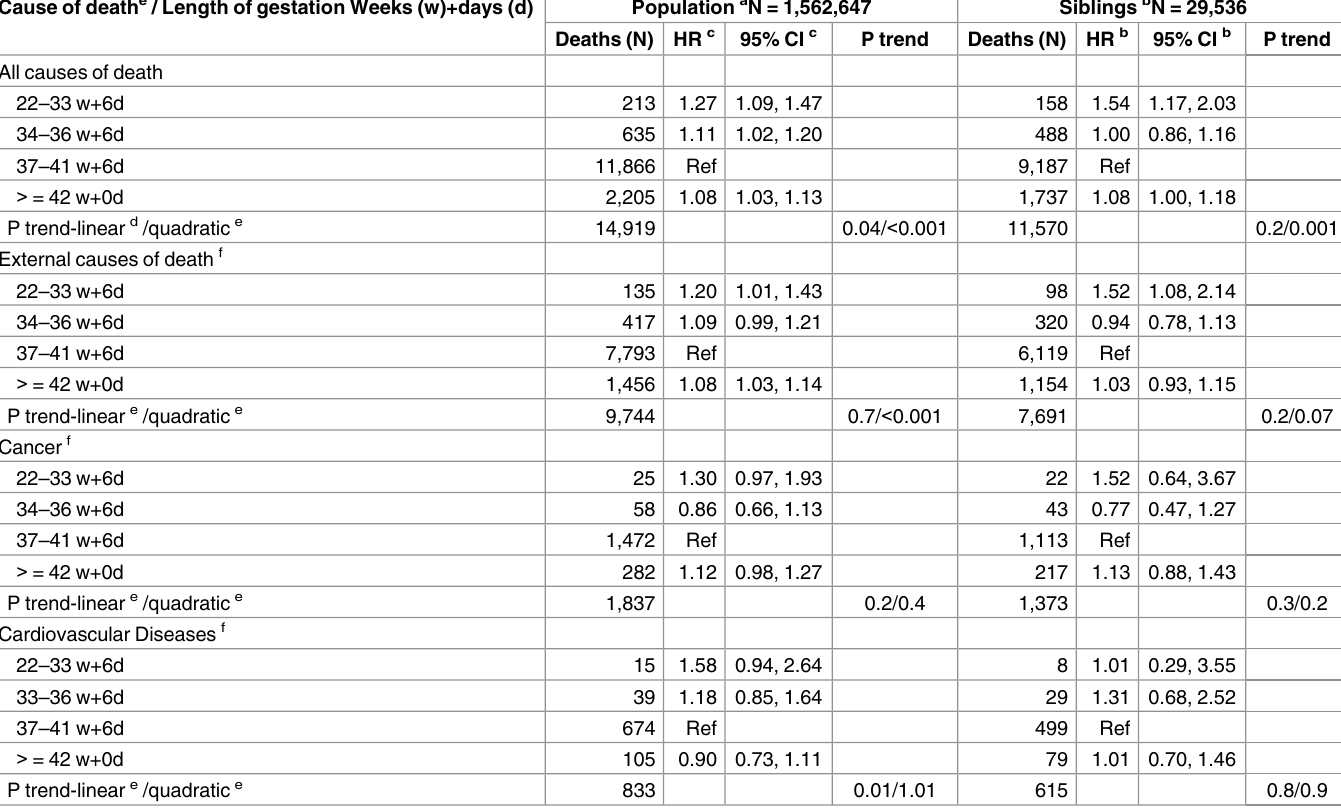
Table 2. Mortality and gestational age by cause of death. Nation-wide cohort born in Norway 1967–1997. Cause of death e / Length of gestation Weeks (w)+days